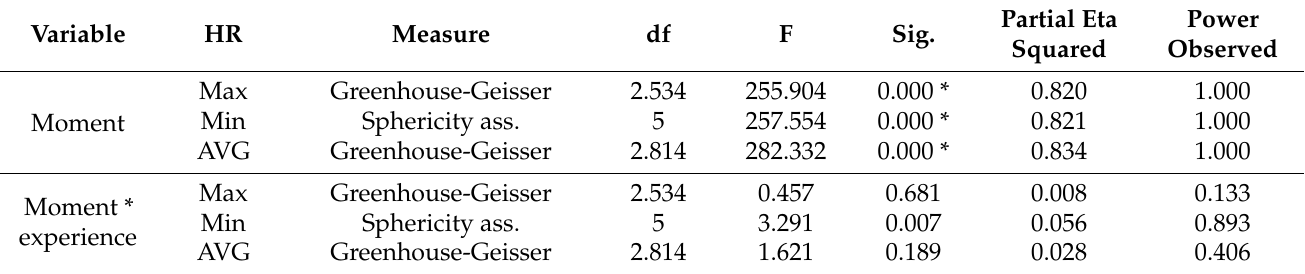
Table 3. Level of significance of the variables with